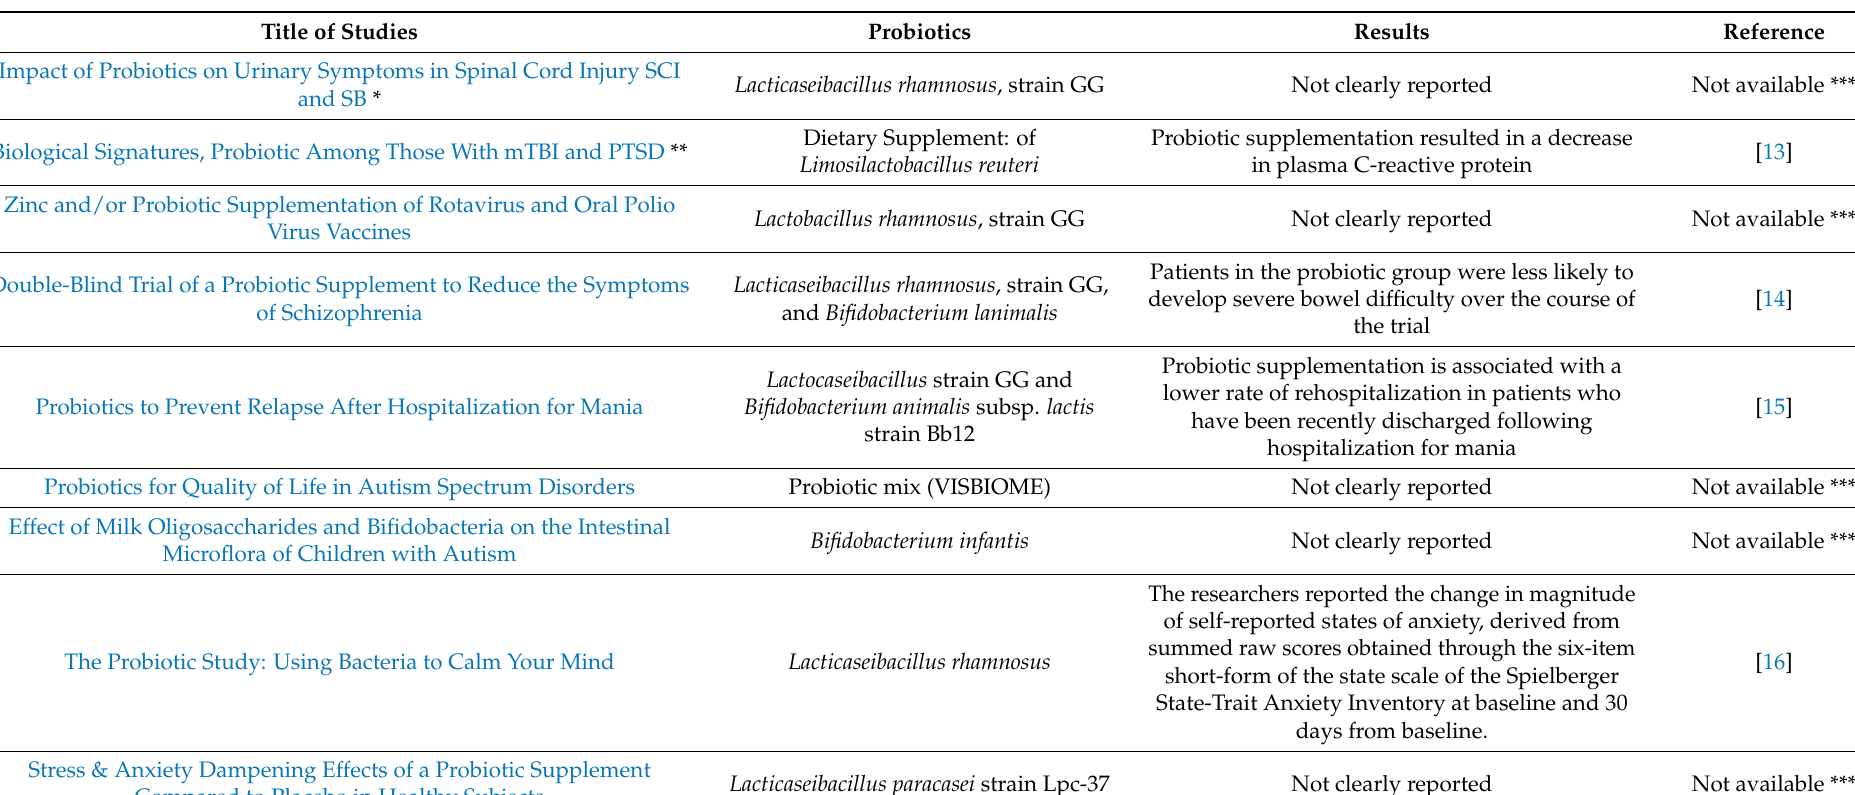
Table 2. Studies selected on ClinicalTrials.gov. The title of the study contains the link to the dashboard of the